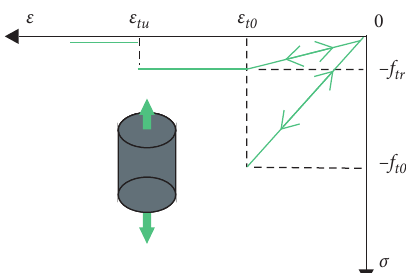
Figure 8: Constitutive relationship of element elastic loss under uniaxial tensile stress.